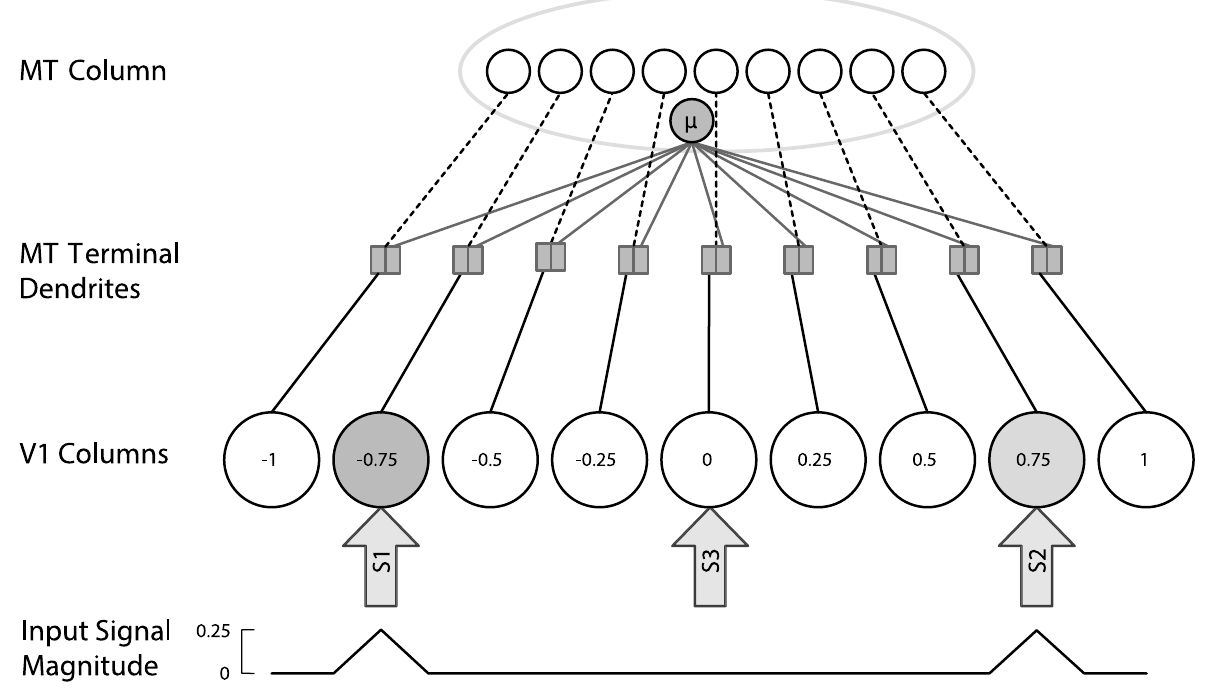
Figure 5. ARC model used for simulations. A single MT column contains 450 visually responsive layer-IV neurons (small white circles), and control neurons (small gray circle) that project a local control signal ( m ) to enable selective attentional processing. Nine V1 columns constitute the receptive field of the MT column and provide feedforward visual signals. The spatial position of V1 columns is indicated inside the V1 columns and the magnitude of the visual signals encoded by each column is shown at the bottom of the figure. Attentional targets for simulations of [3] are shown as arrows (S1, S2, S3), with S3 corresponding to the attend-out/default routing condition.